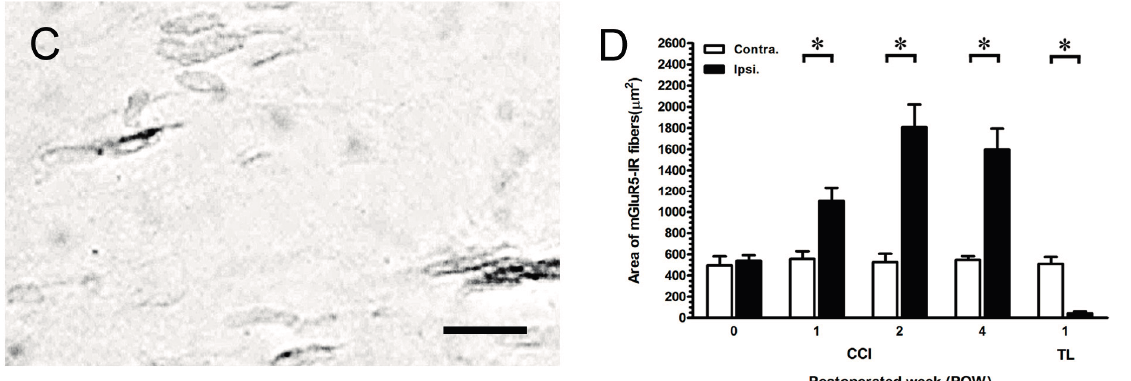
Figure 6. Distribution of mGluR5-IR fibers along the distal compression stumps of sciatic nerve. The sciatic nerves at POW 1 from the ipsilateral sides of ( A ) sham-operated surgery, ( B ) CCI, and ( C ) TL were immunostained with antibody against mGluR5. ( A ) The mGluR5-IR fibers typically expressed the dense linear appearances (blue arrow); ( B ) The more thick forms were presented in mGluR5-IR fibers (blue arrowhead); ( C ) The mGluR5-IR fibers were shown with the weakened occurrences. Scale bar = 25 μ m; and ( D ) The areas of GluR5-IR fibers were quantified as the mean ± SD ( n = 5 at each time points after CCI, n = 5 at POW 1 after TL). Each bar of values showed in the contralateral sides (Contra., open bars) and ipsilateral sides (Ipsi., filled bars). Student’s t test was applied to examine the differences between the Contra. and Ipsi. at the same time points. * p < 0.05, indicated as a significant